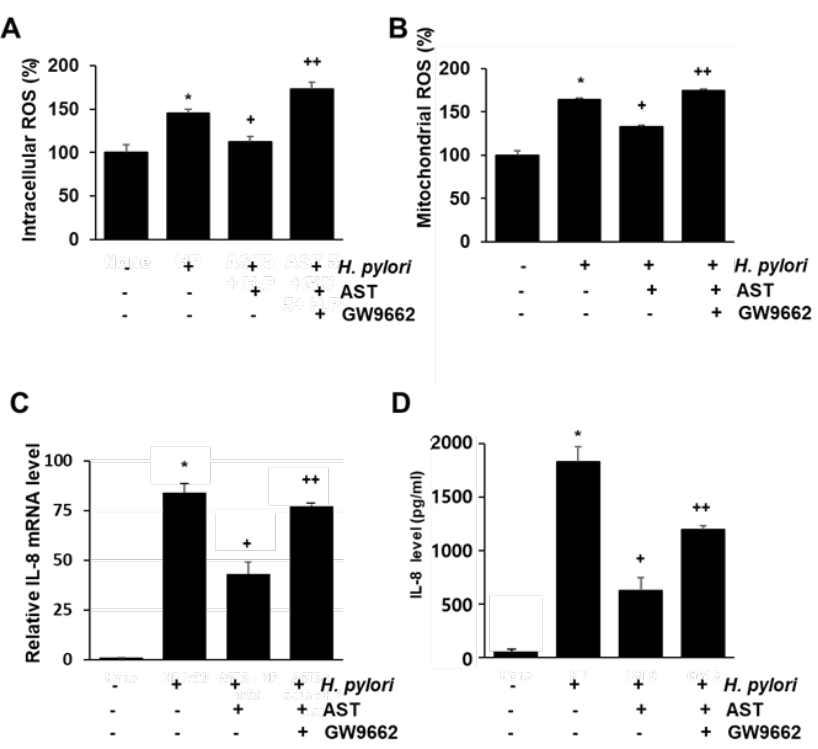
Figure 5. The effect of GW9662 on ROS levels and IL-8 expression in H. pylori —infected AGS cells treated vs not treated with astaxanthin. The cells were treated with astaxanthin (5 µ M) for 3 h without, or in combination with, the PPAR- γ antagonist GW9662 (5 µ M), and then stimulated with H. pylori for 1 h (for intracellular and mitochondrial ROS levels), 4 h (for IL-8 mRNA level), and 24 h (for IL-8 protein level in the medium). ( A ) A plot of the relative intracellular ROS levels measured by DCF-DA fluorescence. ( B ) A plot of the relative mitochondrial ROS level measured by MitoSOX fluorescence. ( C ) A plot of the relative mRNA expression of IL-8 determined by real-time PCR analysis. ( D ) A plot of the concentration of IL-8 in the media determined by ELISA. * p < 0.05 vs. cells without any treatment or stimulation; + p < 0.05 vs. cells with H. pylori stimulation alone; ++ p < 0.05 vs. cells with astaxanthin treatment and H. pylori stimulation. “ − “ means without treatment or stimulation. “+” means with treatment or